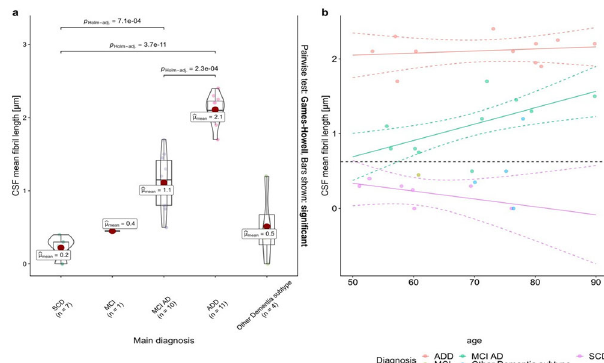
Fig. 5 Correlation of fi bril length obtained from AFM measurements and CSF with patient diagnostic classi fi cation. a Combined box and whiskers and violin plots in the style of Tukey of the mean of CSF fi bril length per patient group. The mean fi bril length was signi fi cantly higher in ADD than in MCI and SCD patients as well as higher in MCI AD than SCD patients (Games-Howell pairwise post-hoc tests). b CSF fi bril length plotted against the age as a function of the group. Regression lines with 95% CI depict the ‘ age x diagnosis ’ interaction effect on CSF fi bril length based on a linear regression model with the predictors ’ age, diagnosis and the interaction ‘ age x diagnosis ’ fi tted for patients with either SCD, MCI AD or ADD ( n =